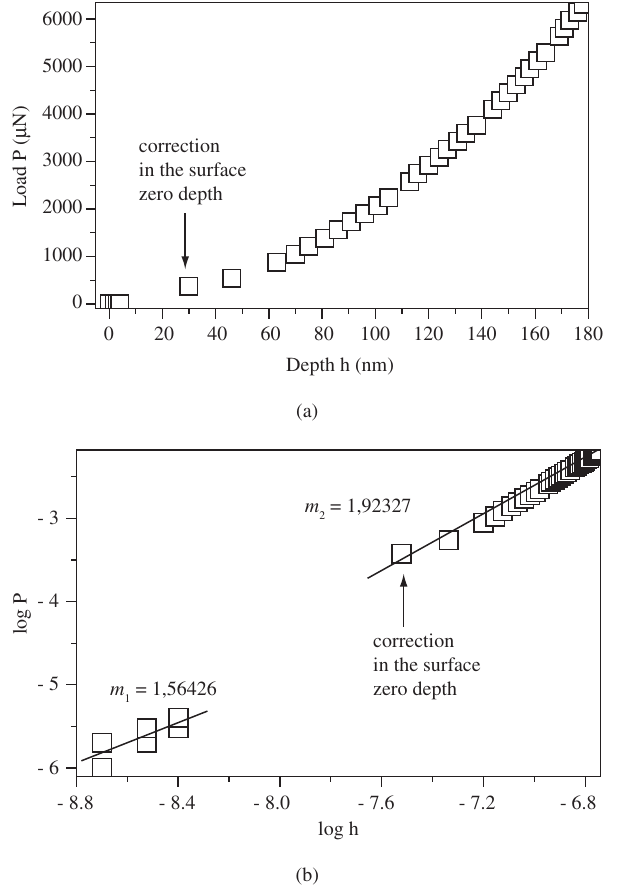
Figure 4. a) Initial portion of the loading curve; and b) the same curve linearized, for a nanoindentation test of the sample treated at 60%N and 600 °C. The arrows indicate the same experimental point in both plots.